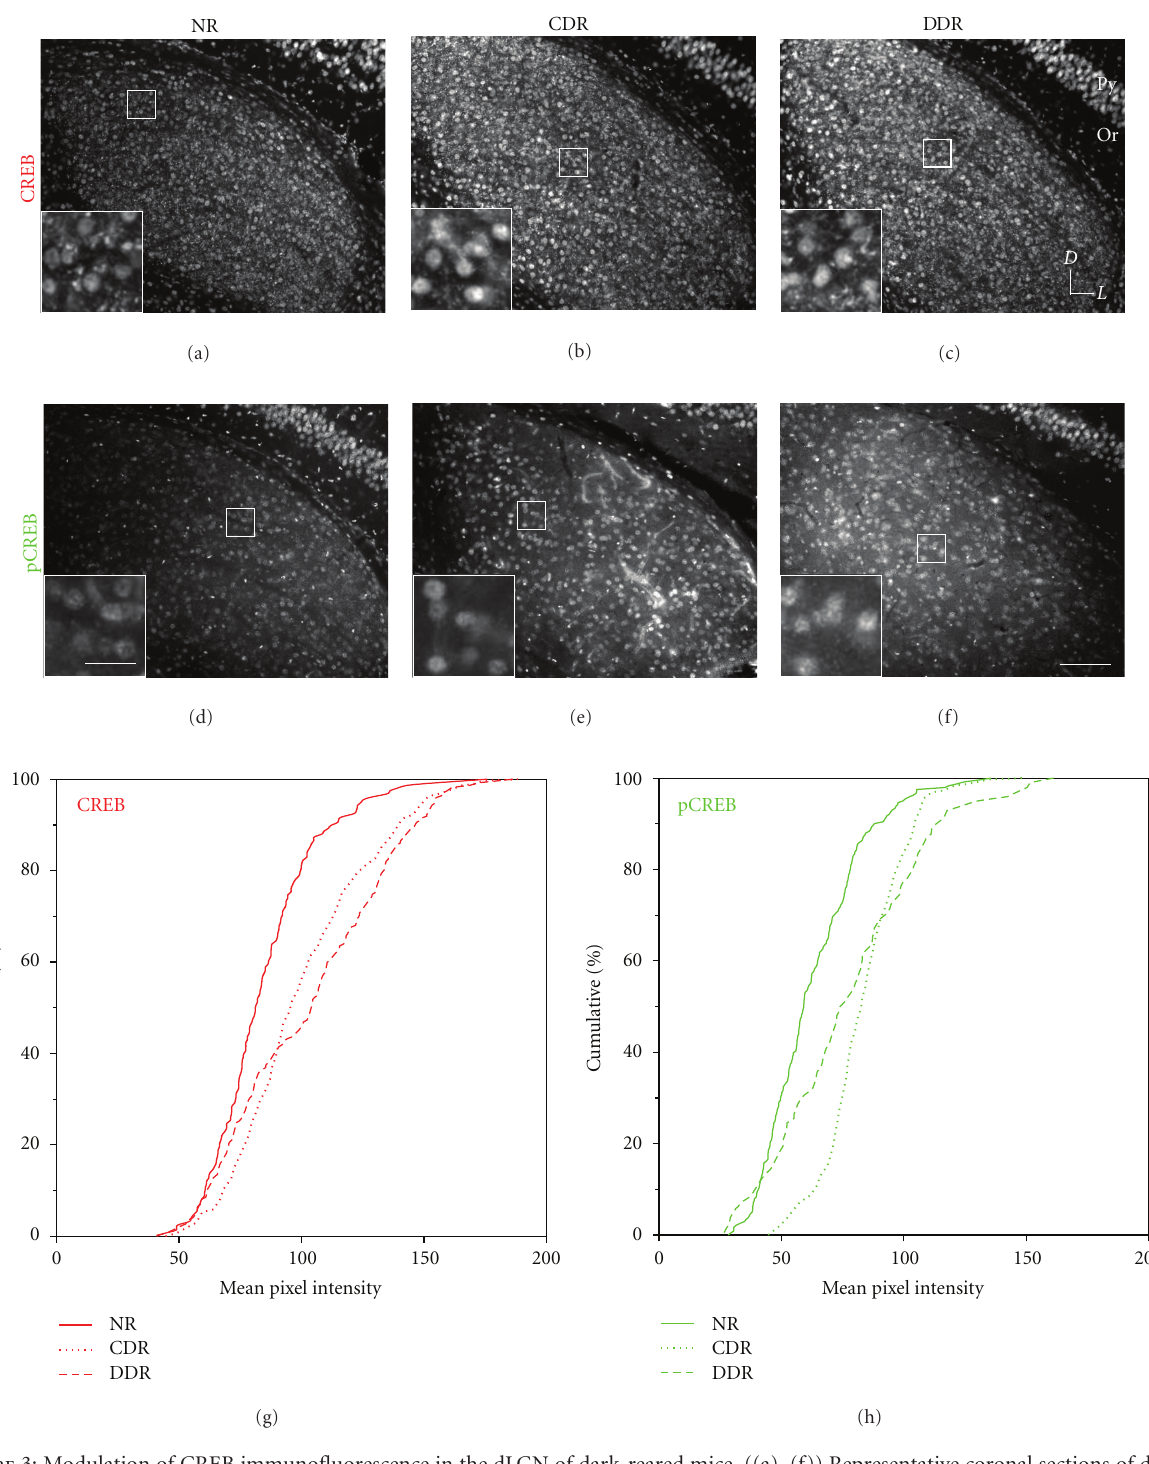
Figure 3: Modulation of CREB immunofluorescence in the dLGN of dark-reared mice. ((a)–(f)) Representative coronal sections of dLGN showing the labeling of total CREB ((a)–(c)) and pCREB ((d)–(f)), in NR ((a) and (d)), CDR ((b) and (e)), and DDR ((c) and (f)) mice. Corresponding high-magnification insets show that staining was prominent in somata. Py, pyramidal cell layer of hippocampus; Or, oriens layer of hippocampus; D, dorsal; L, lateral. Scale bars, 100 μ m and 25 μ m. ((g) and (h)) Cumulative histograms of cellular fluorescence intensity measured in somata in NR, CDR, and DDR for total CREB (g) and pCREB (h). Note that, for both total CREB and pCREB, CDR and DDR significantly shifted the distribution of fluorescence intensity toward larger values when compared to NR (the Mann-Whitney tests, P < 0 . 0001 for all comparisons). For CREB; NR n = 159 cells, CDR n = 267, DDR n = 224; for pCREB; NR n = 242 cells, CDR n = 276, DDR n = 144; from 2–6 dLGNs per